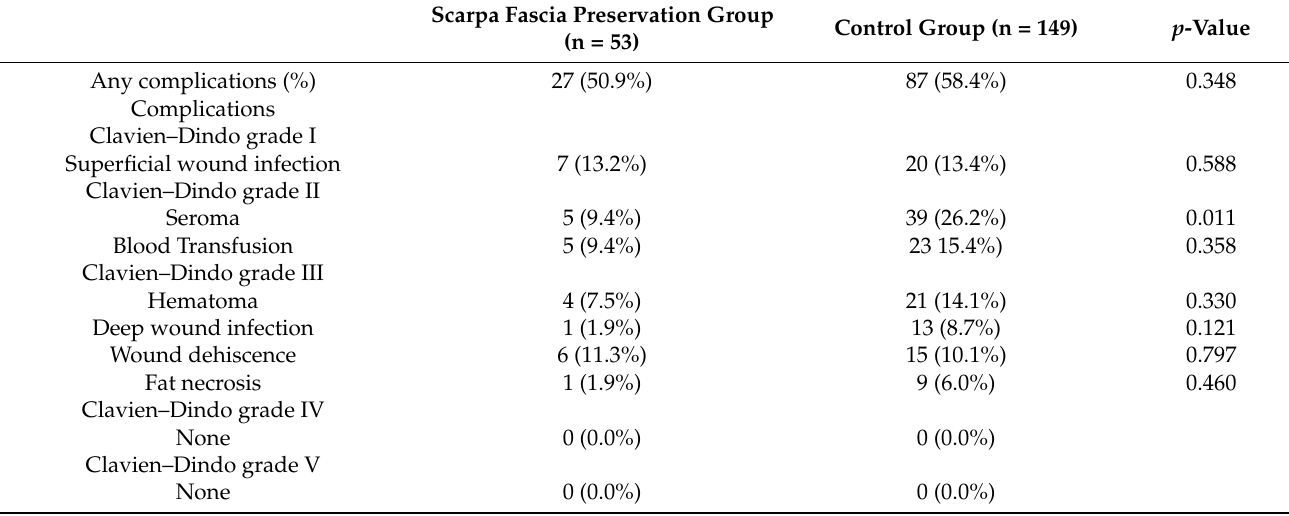
Table 3. Postoperative complications at